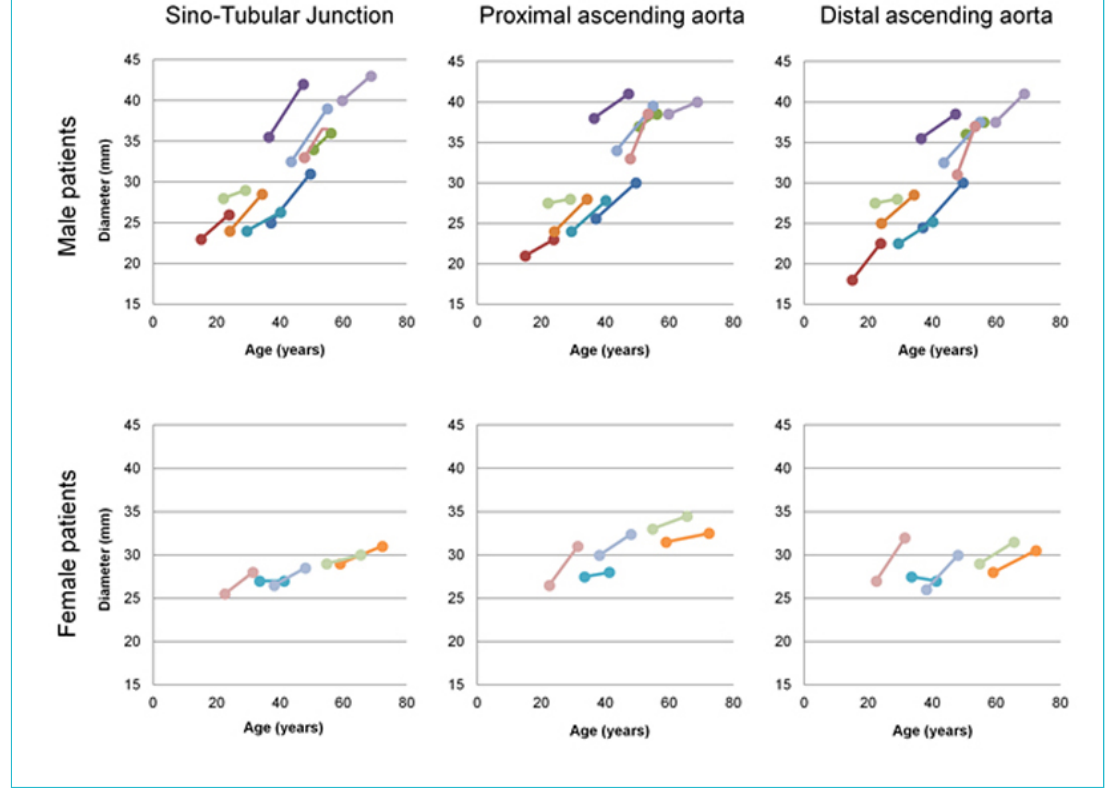
Figure 3: Individual profiles of aortic diameter increase in male and female patients with Fabry